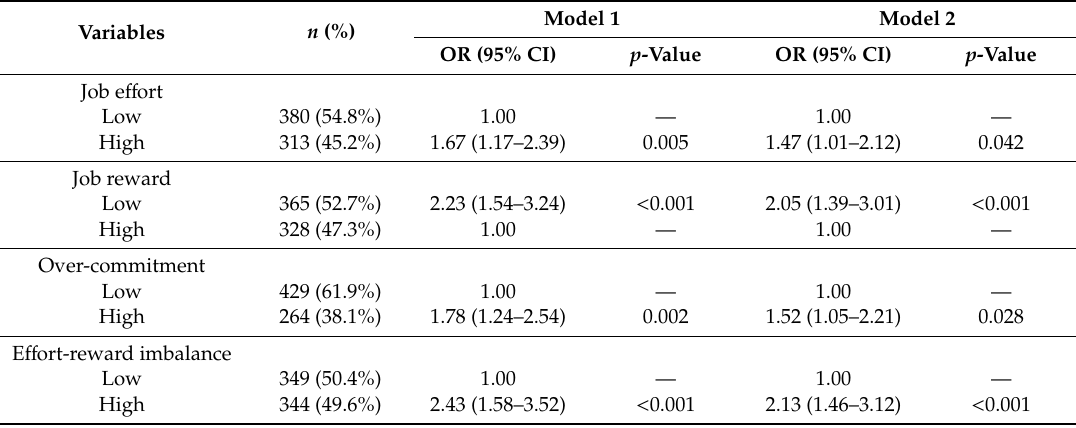
Table 4. Logistic regression analysis job stress in relation to sleep dysfunction.